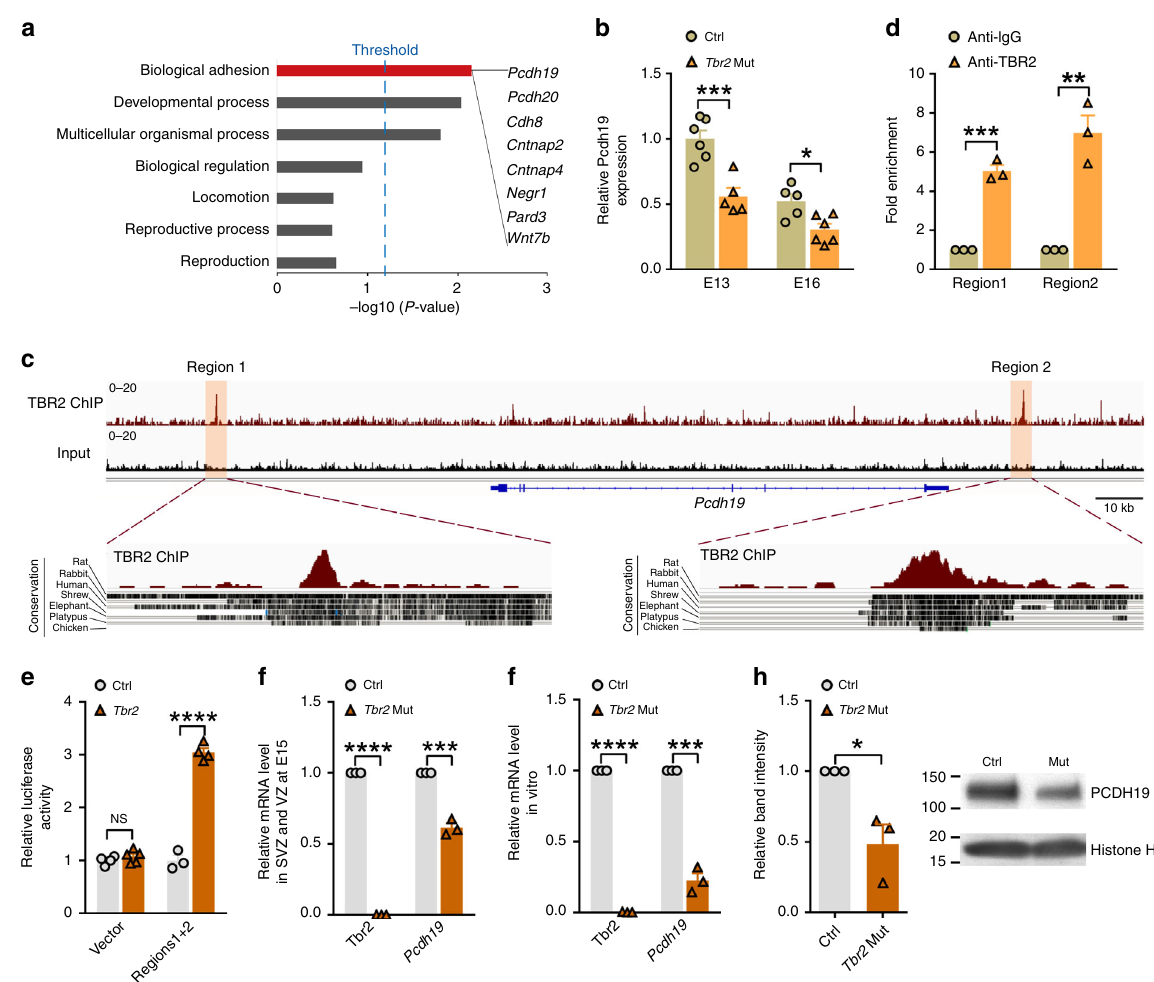
Fig. 4 TBR2 regulates Pcdh19 expression by two evolutionarily conserved binding sites. a Overrepresentation analysis of differentially expressed genes in the Tbr2 Mut IPs compared with the control IPs based on microarray analysis. Threshold: Benjamini adjusted p value < 0.05. b Reduced Pcdh19 expression in the Tbr2 Mut IPs compared with the control at E13 and E16 based on microarray analysis ( n = 5 – 6) (* P < 0.05, *** P < 0.001; two-way ANOVA, Benjamini Hochberg FDR used for P value adjustment). c Two evolutionarily conserved TBR2 binding sequences located upstream and downstream of Pcdh19 based on ChIP-seq analysis in the E14 mouse cortex. The binding sequences 1 and 2 are highlighted (regions 1 and 2) and evolutionarily conserved regions are shown at the bottom. d The enrichment of TBR2-bound sequences 1 and 2 upstream and downstream of Pcdh19 determined by ChIP-qPCR in the E14 mouse cortex ( n = 3). e Increase in the relative luciferase activity driven by the TBR2 binding sequences 1 and 2 upstream and downstream of Pcdh19 in the presence of TBR2 ( n = 4). f Decrease in Pcdh19 mRNA in the Tbr2 mutant cortex at E15 compared with the control determined by RT-qPCR ( n = 3). g Decrease in Pcdh19 mRNA in the Tbr2 mutant cortical neural progenitors cultured in vitro compared with the control determined by RT-qPCR ( n = 3). h Decrease in PCDH19 protein expression in the Tbr2 mutant cortical neural progenitors cultured in vitro compared with the control determined by Western blot ( n = 3). Data are presented as mean ± SEM. (* P < 0.05; ** P < 0.01; *** P < 0.001; **** P < 0.0001; NS not signi fi cant; unpaired Student ’ s t